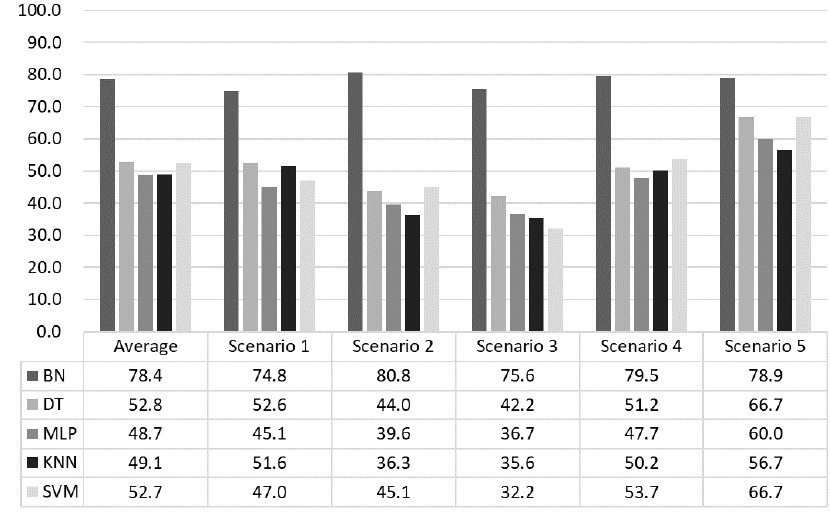
Figure 13. Emotion prediction accuracy.